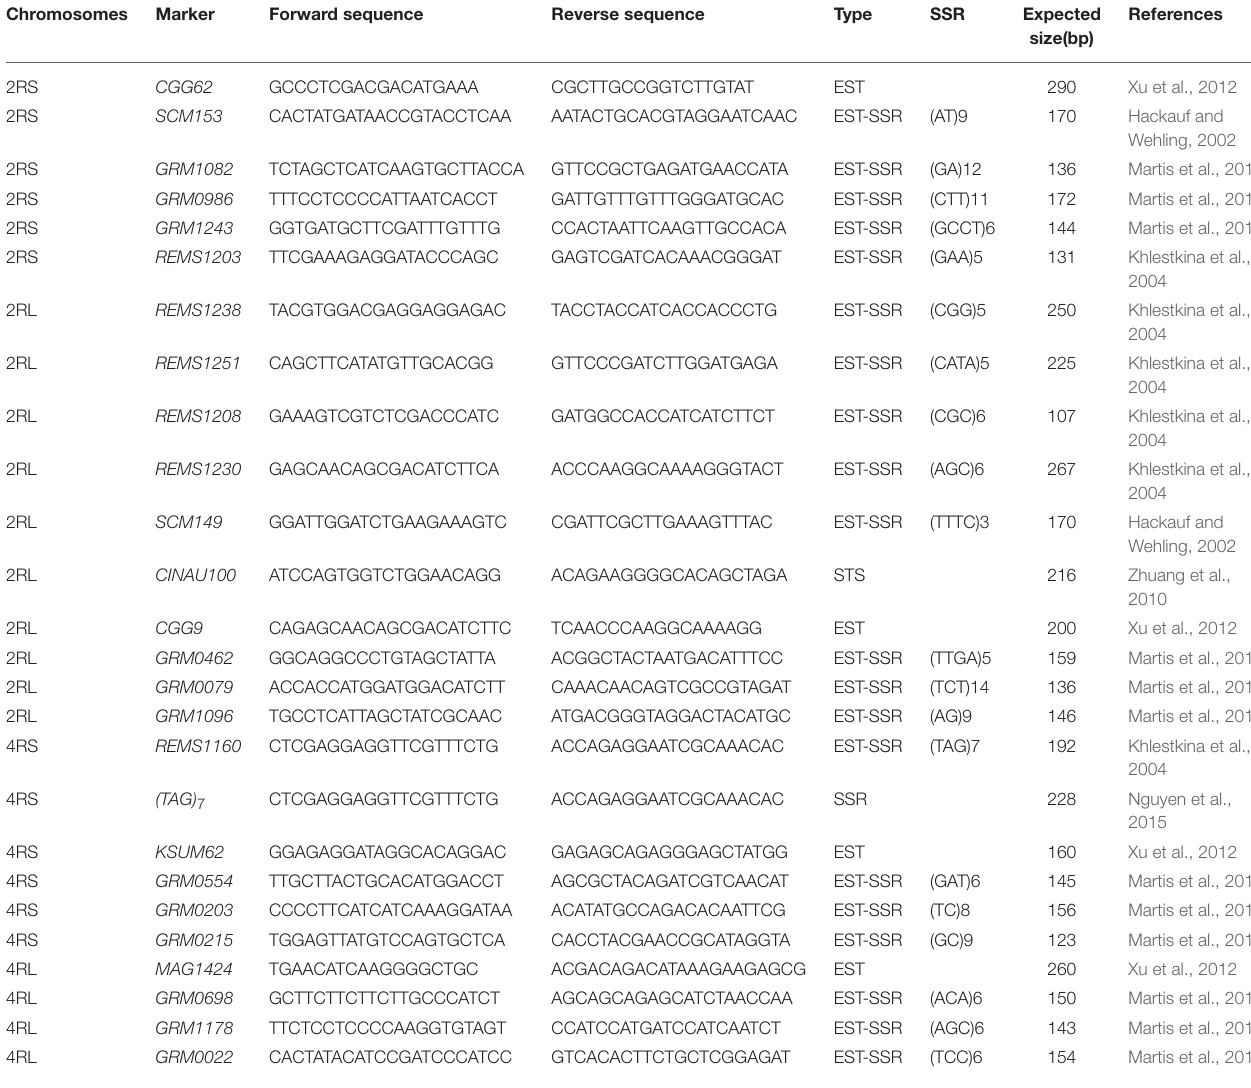
TABLE 3 | Arm-specific markers used for detecting rye chromosomes 2R and 4R.